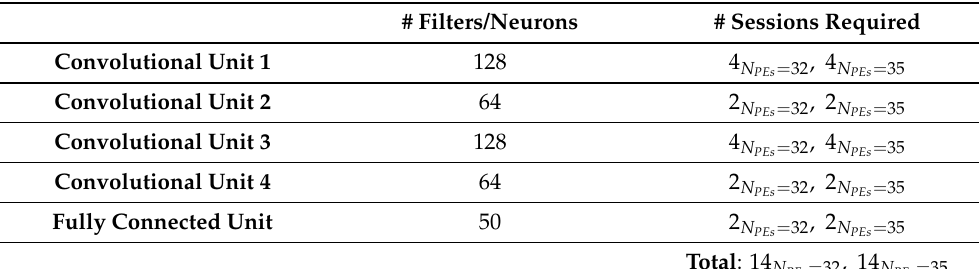
Table 9. Number of executing sessions required to compute each ECG-ID-BNet layer, in function of N PEs